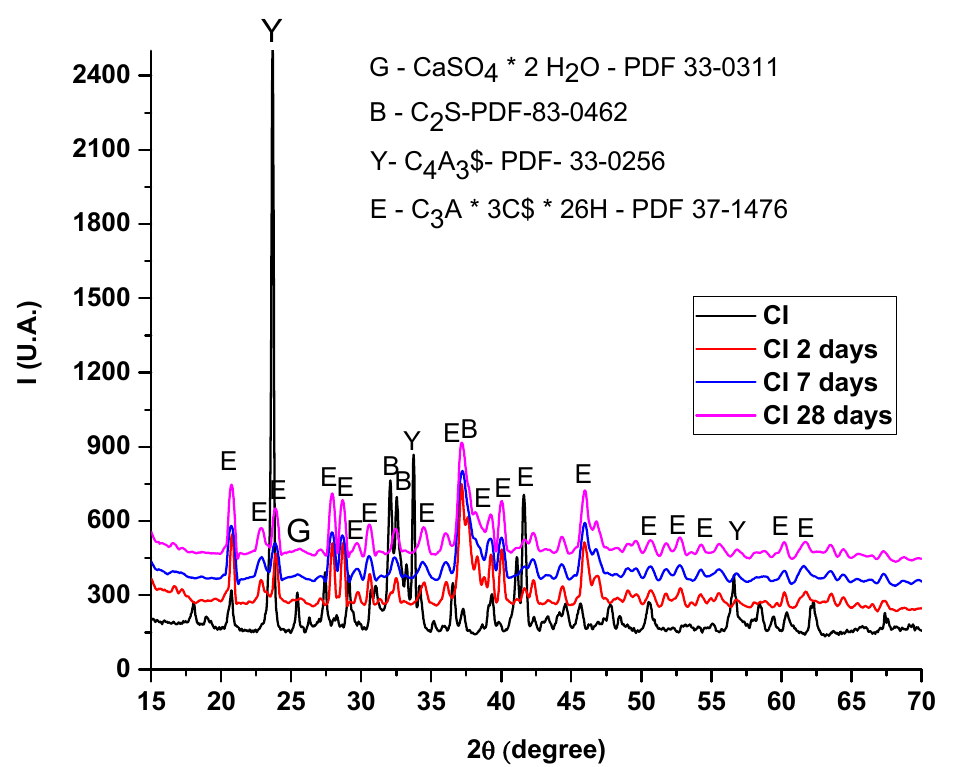
Figure 4. X-ray diffraction pattern on sintered clinker and different curing time. (C-CaO, S-SiO 2 , A-Al 2 O 3 , $-SO 3 , H-H 2 O).